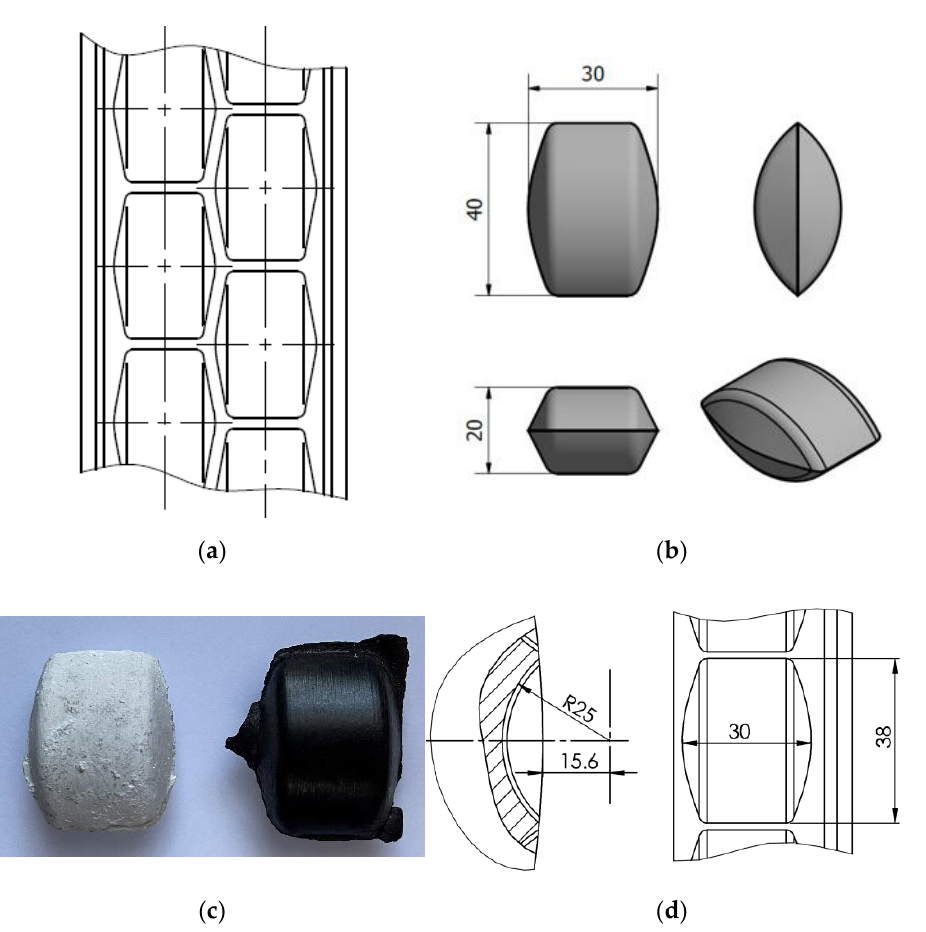
Figure 4. Geometry of molding cavities on the working surface of rollers used for tests: ( a ) front view or working surface, ( b ) the dimension of the consolidated briquette, ( c ) the real briquettes, and ( d ) dimensions of the forming cavity. (unit: mm).